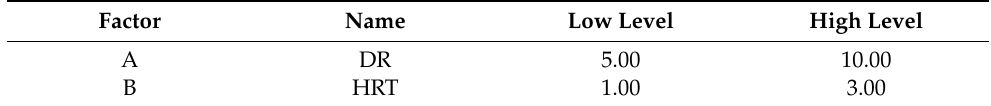
Table 3. DR and HRT values used to design the OLR through CCD-RSM.